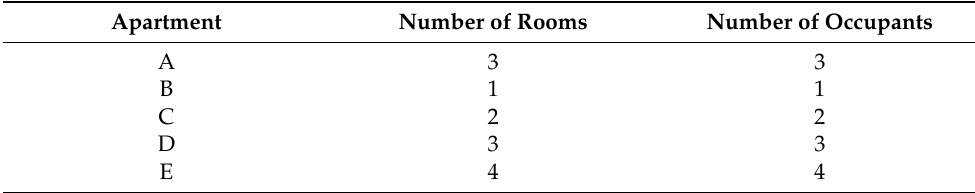
Table 2. The total number of occupants in each apartment type. Apartment Number of Rooms Number of Occupants A 3 3 B 1 1 C 2 2 D 3 3 E 4